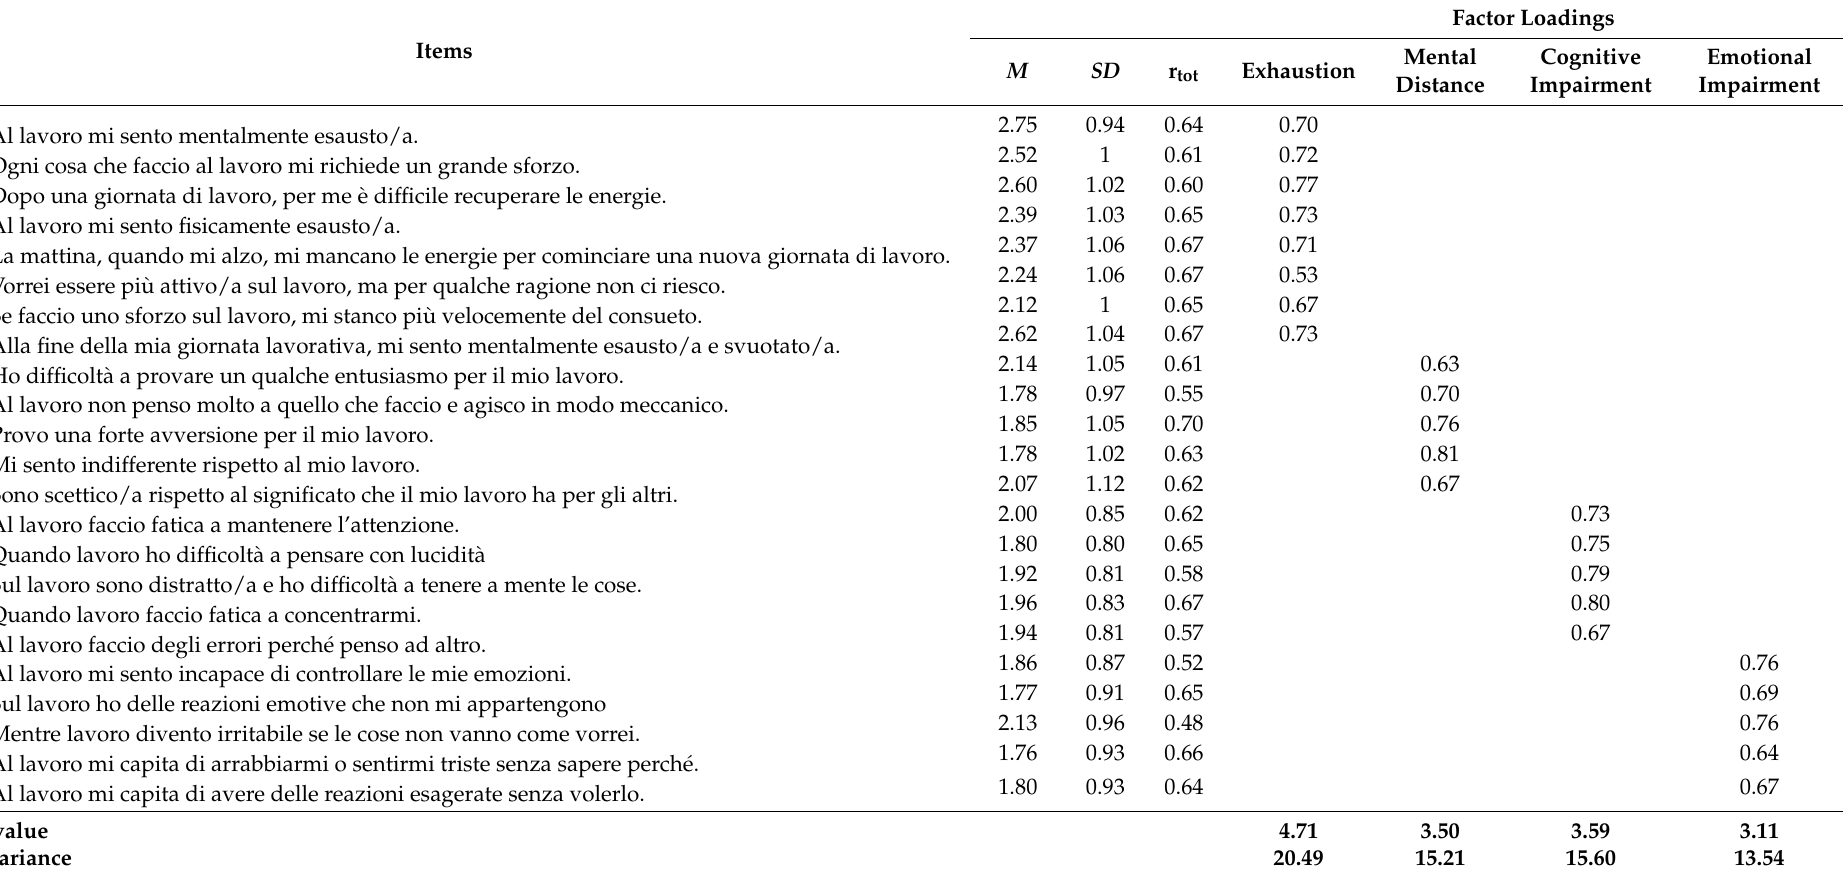
Table 2. Exploratory factor analysis results of the BAT Core Symptoms